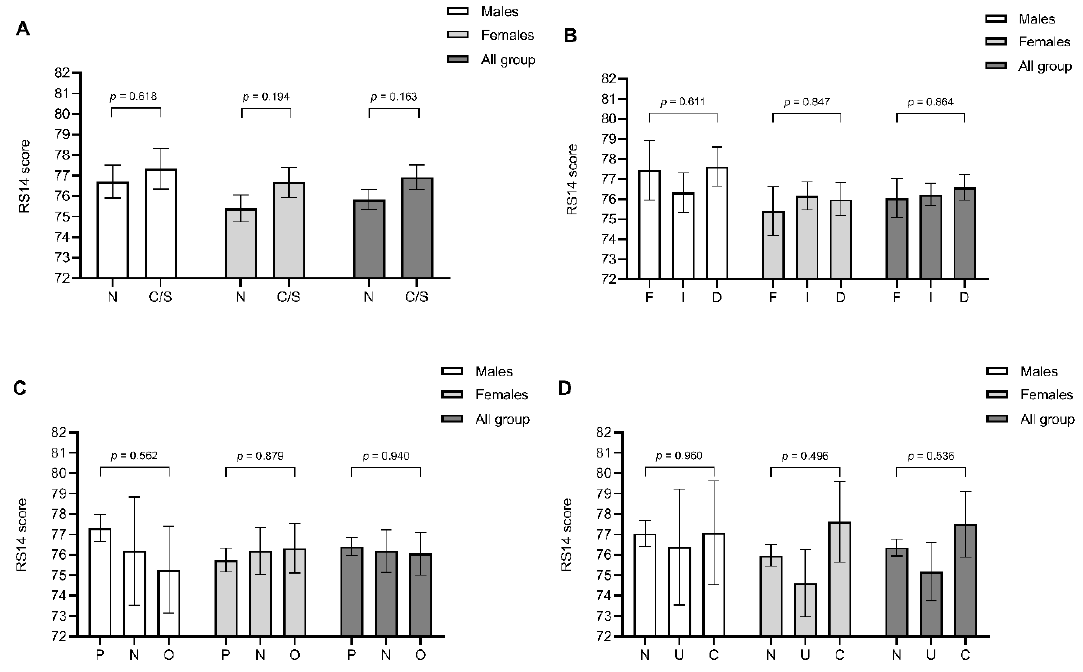
Figure 2. Levels of resilience measured through the 14-item Resilience Scale (RS14) in healthcare professionals after stratification for geographical area ( A ), work setting ( B ), role ( C ), and development of symptomatic COVID-19 ( D ). Data are expressed as mean and standard error of the mean and are stratified according to gender. In panel ( A ): N = Northern Italy, C / S = Central and Southern Italy. In panel ( B ): F = COVID-19-free setting, I = Indirect COVID-19 care, D = Direct COVID-19 care. In panel ( C ): P = Physicians, N = Nurses, O = Other roles. In panel ( D ): N = Never diagnosed with COVID-19, U = Uncertain symptoms of COVID-19, C = Confirmed diagnosis of symptomatic COVID-19.